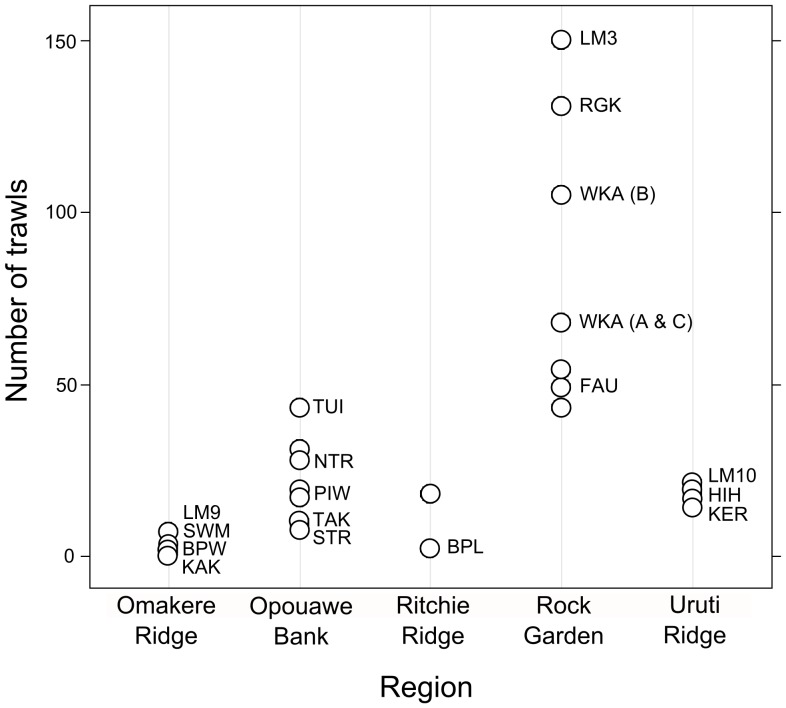
Trawl intensity at seep sites by region.Selected seep sites are identified by name (see Table 1 for full names). Trawl data are cumulative totals for the period 1989–90 to 2004–5 [24] calculated as the number of trawl tracks intersecting a 250 m radius circle around seep site positions given in Greinert et al. [12].